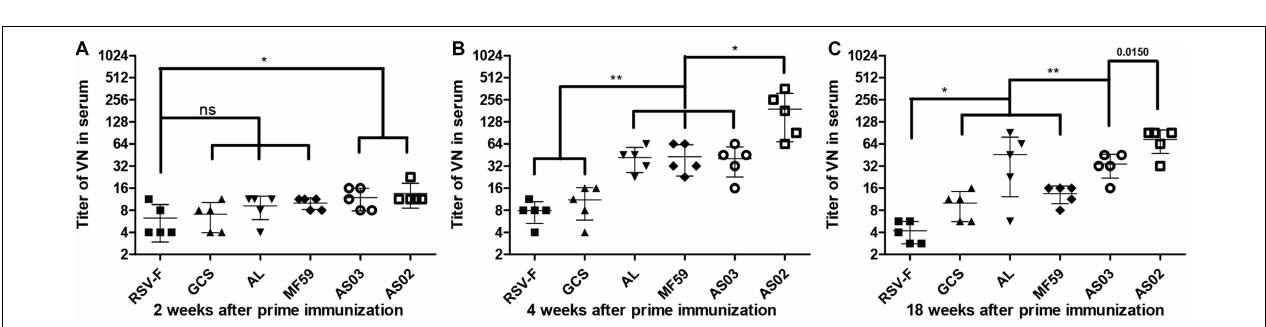
FIGURE 3 | RSV/A/long-neutralizing antibody levels in the sera of mice intramuscularly immunized with various adjuvanted vaccines and RSV-F alone at weeks 0 and 2. The sera of five mice in each group was separately tested at 2 (A) , 4 (B) , and 18 (C) weeks by plaque assay. Results are shown as mean ± SD of neutralizing antibody titers calculated from all five mice in each group. “ns” P ≥ 0.05, * P < 0.05, ** P < 0.01 between two different groups.